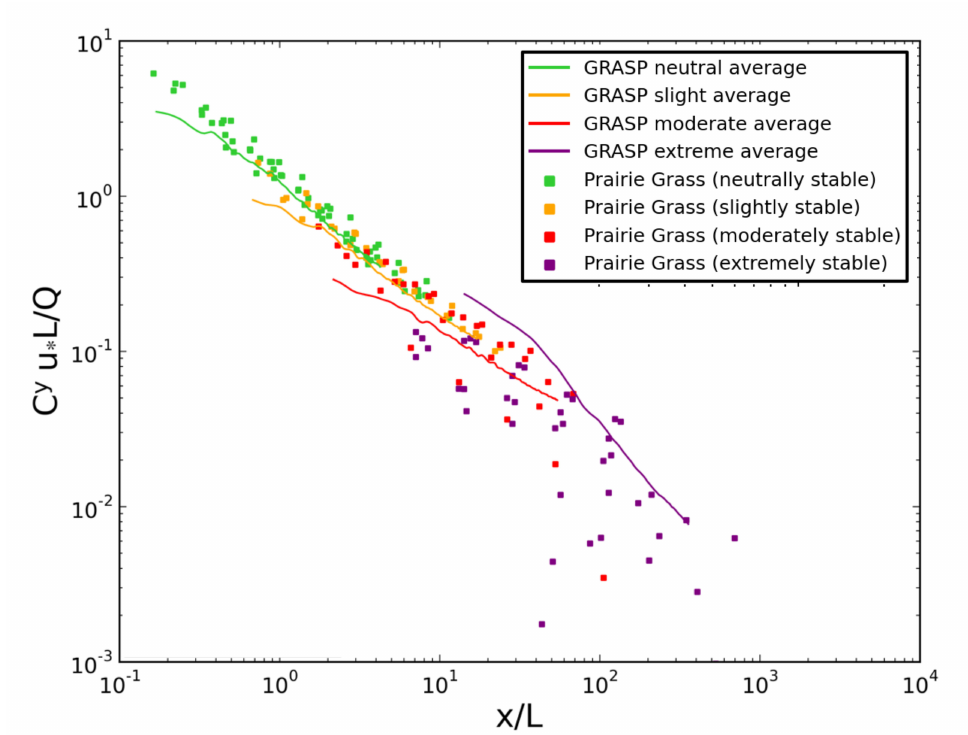
Figure 14. A summary of the GPU-LES dispersion simulation results for the neutral and stable boundary layer simulations. Each of the lines represents an ensemble average of 18 simulations. The dots represent observations from the Prairie Grass experiment during neutral and stable conditions. The results demonstrate that the GPU-LES can accurately represent atmospheric dispersion for conditions ranging from neutral to stable